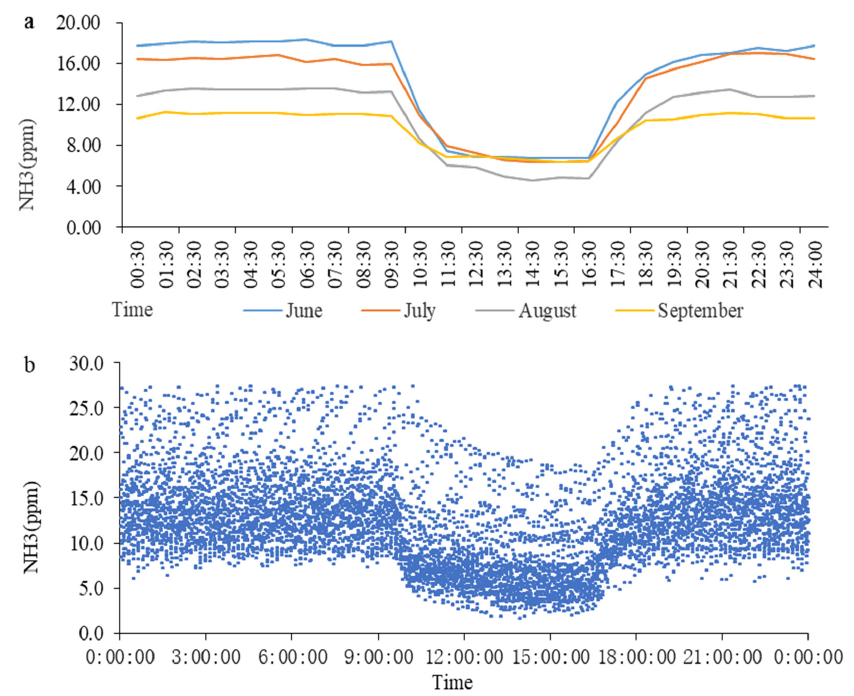
variation trends in NH 3 concentration all day; ( b ) The variation trends in NH 3 concentration during the light period (9:30–16:30); ( c ) The variation trends in NH 3 concentration during the dark period (16:30–9:30 next day).